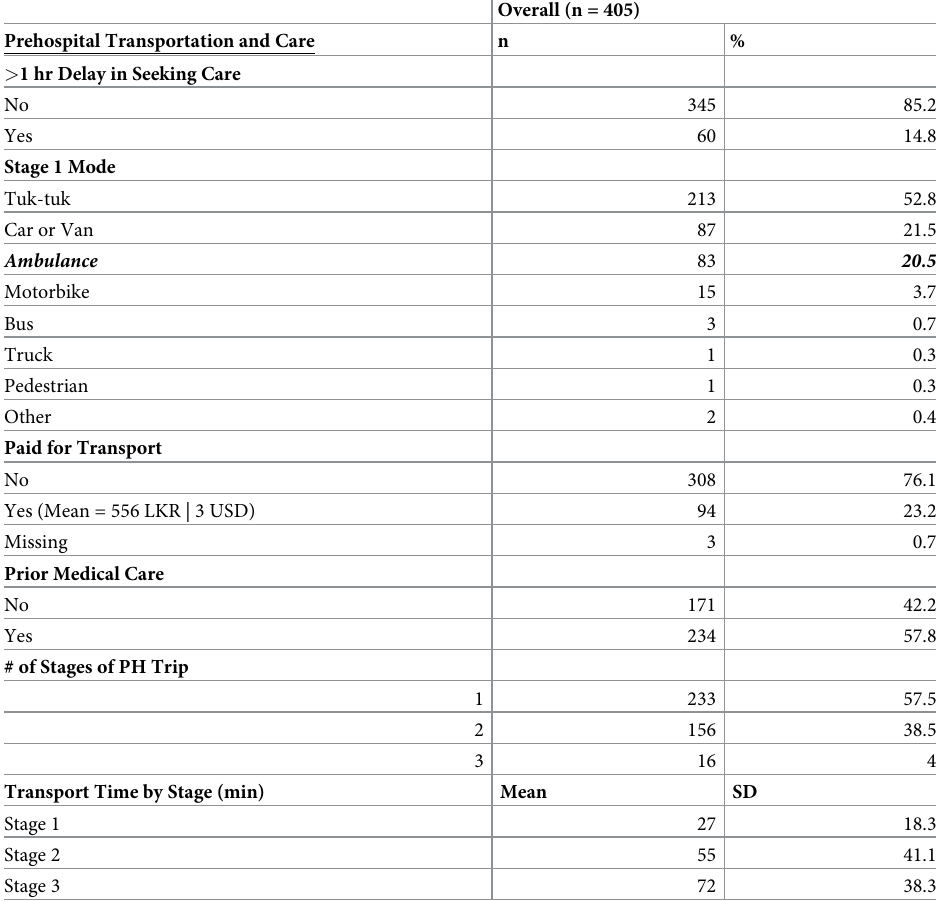
Table 3. Prehospital transportation and care